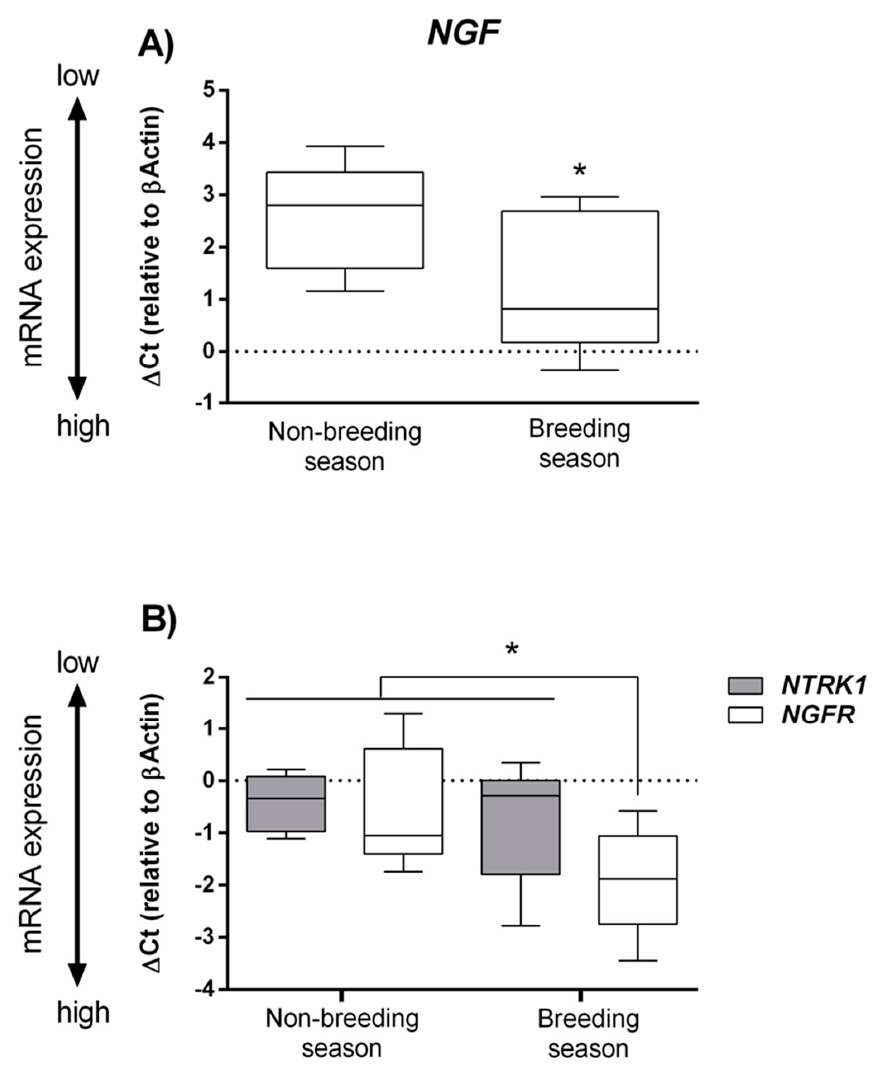
Figure 4. Box-and-whisker plots of nerve growth factor ( NGF ; panel A ) and neurotrophic tyrosine kinase receptor 1 ( NTRK1 ) and nerve growth factor receptor ( NGFR ) (panel B ) transcription values (medians and 95% confidence intervals) in ovaries of grey squirrels during breeding (January–February) and nonbreeding (July–November) seasons. Data are shown as ∆ Ct (relative to β -actin) values, with higher ∆ Cts representing lower expression (Welch’s ANOVA / Welch’s t -test: * p < 0.05).